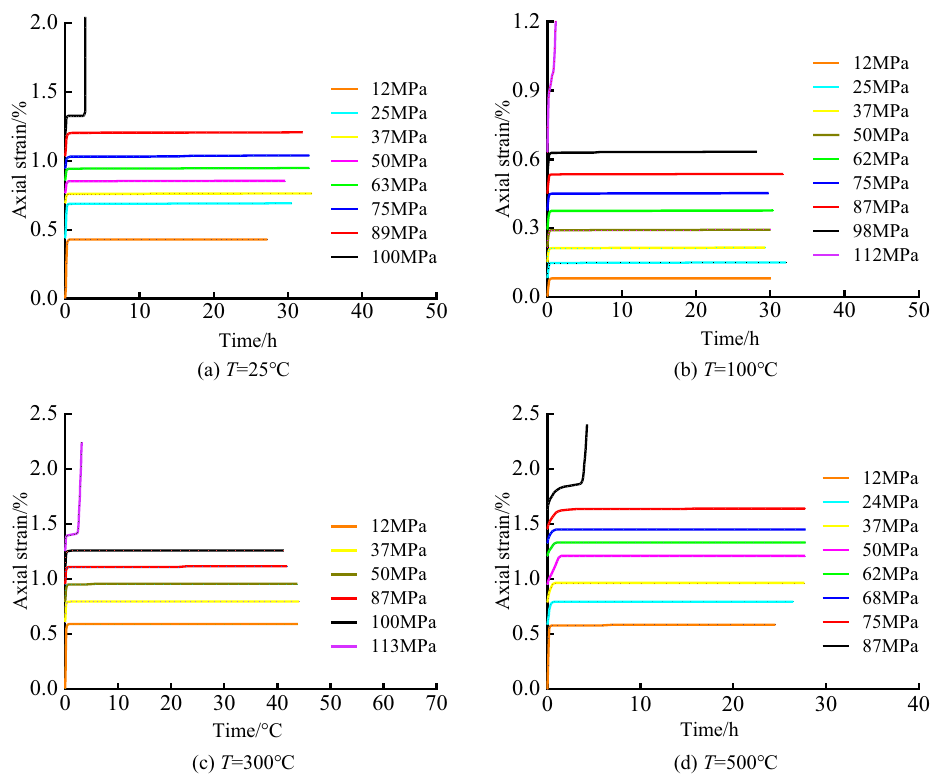
Figure 1. Triaxial compression creep curves of limestone under different temperature